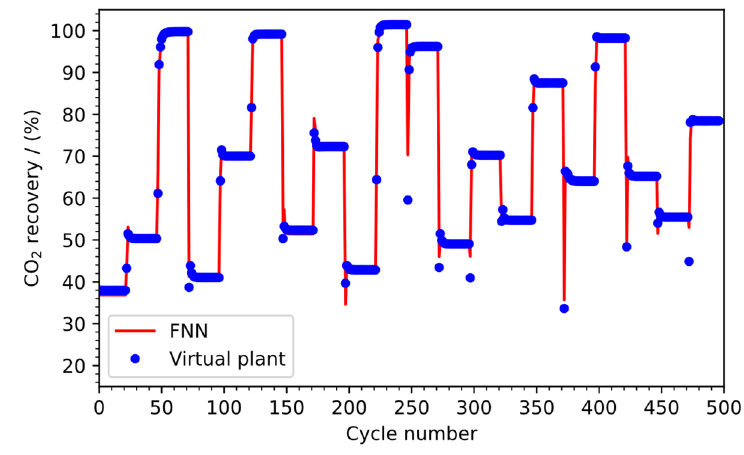
Figure 7. FNN test performance.